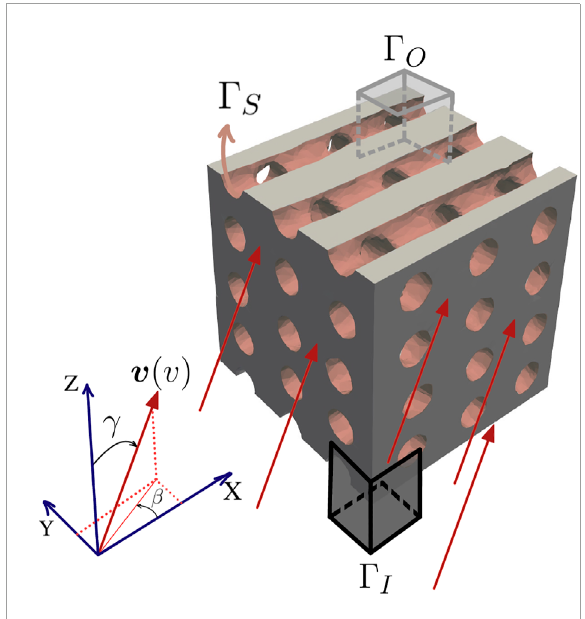
FIGURE 1 Domain for the interstitial fluid across a representative volume of the 3D-printed structured scaffold. The three dark grey faces (through the origin) mark the inlet faces, Γ I , where Dirichlet conditions are set to 0. The opposite light grey faces correspond to the outlet, Γ O . Light red surfaces indicate the scaffold-fluid interface, Γ S , where the release Robin conditions are